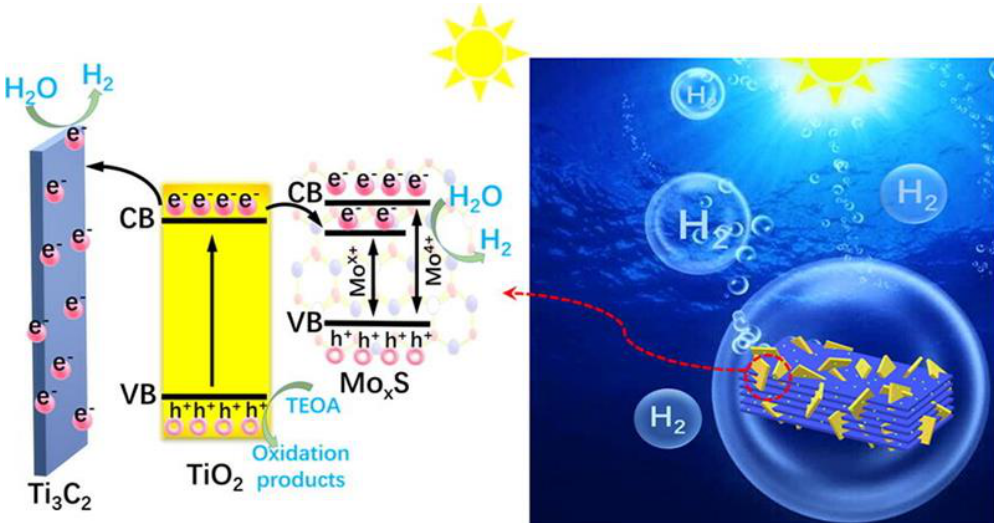
Figure 6. A photocatalytic mechanism for H 2 production using Mo X S/MXene via water splitting. (Reprinted with permission from Ref. [101]. 2020 Elsevier).